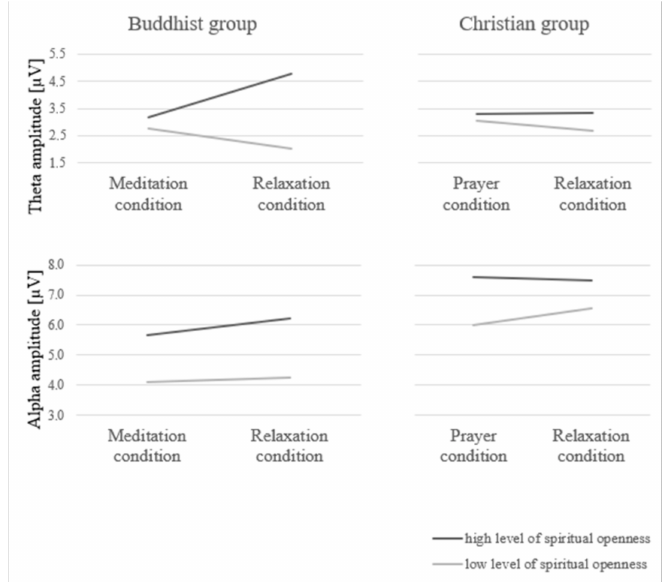
Figure 2. Theta and alpha amplitude at Pz (as per the 10–20 system) in the Buddhist and Christian groups in conditions of high and low level of spiritual